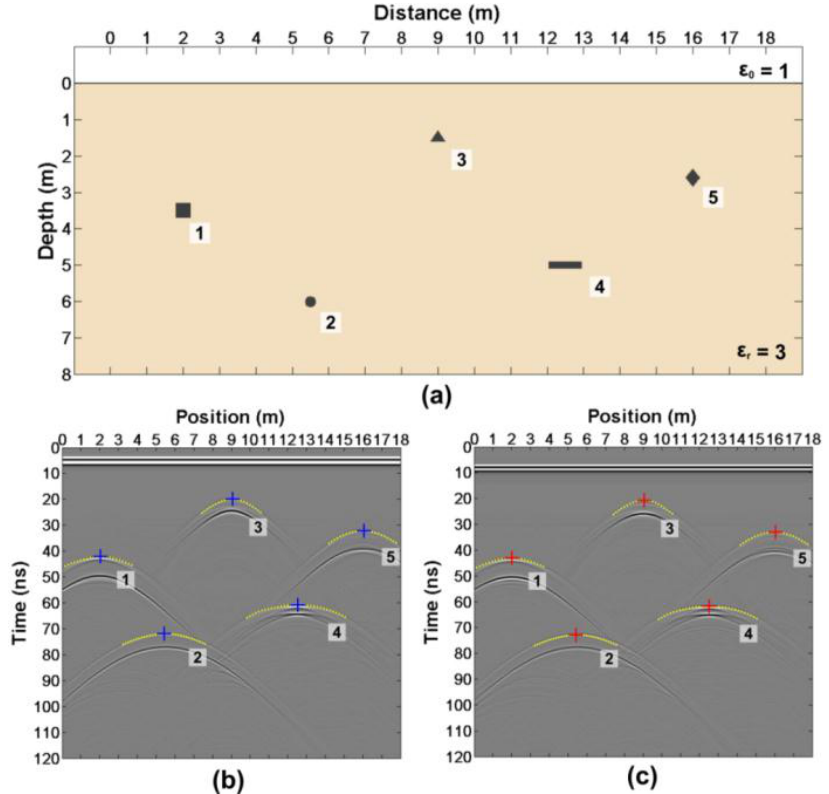
Figure 7. ( a )The simple model; ( b )The forward result with an offset of 1m; and ( c )Forward result with an offset of 2m.